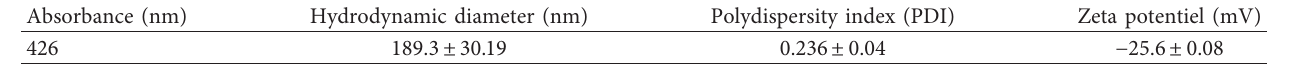
Figure 1: Ultraviolet-visible absorption spectra of AgNPs synthesis using the dried peel of orange ( Citrus sinensis ) extract (AgNO (a), aqueous orange peel extracts (b), and AgNPs (c)). Table 1: Characterization and stability of the synthesized AgNPs using orange peel